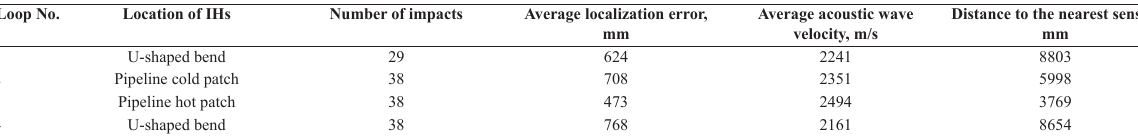
Table 1. Experimental results. Loop